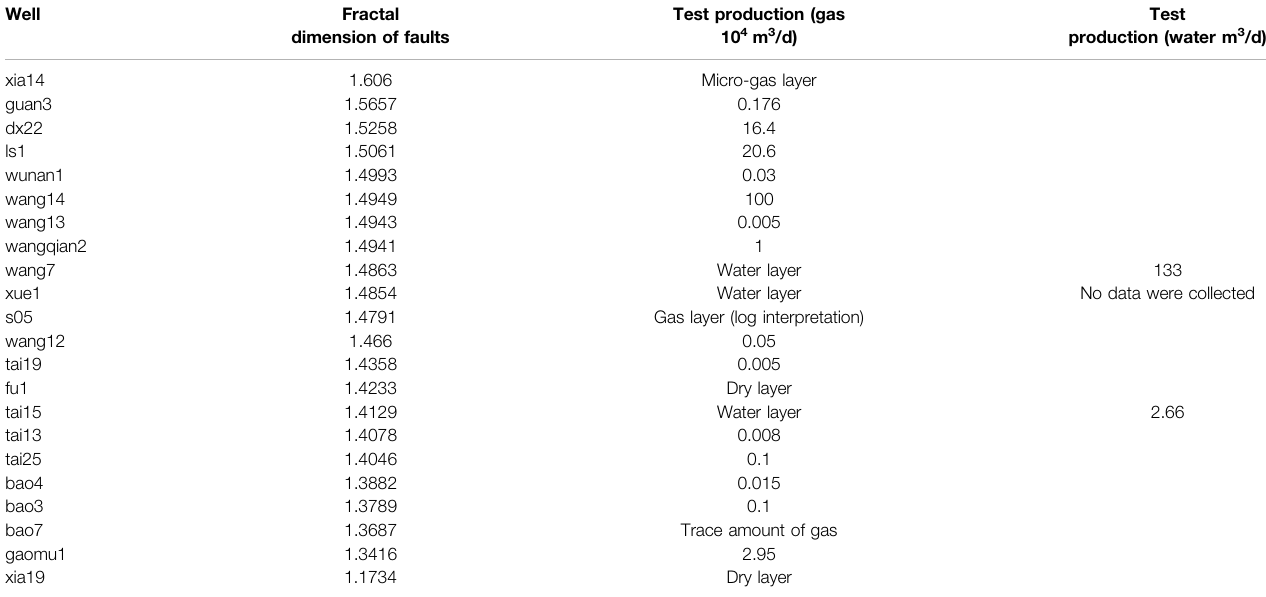
TABLE 1 | Fractal dimensions of faults and well test results. Well Fractal dimension of